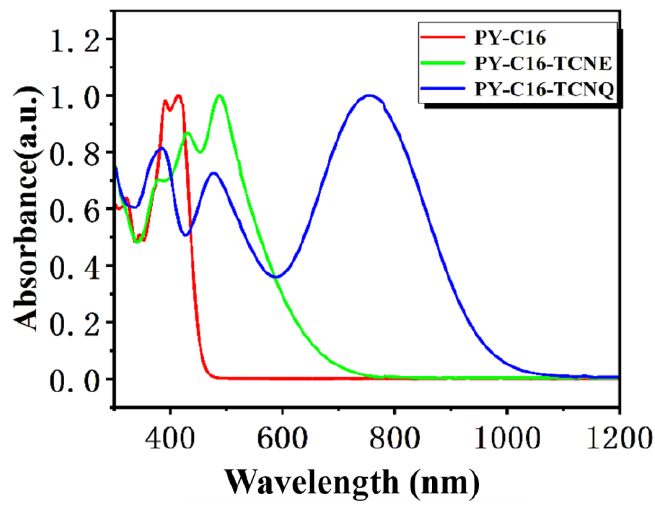
Figure 2. Normalized UV-vis absorption spectra of compound PY-C16 and click products PY-C16- TCNE, PY-C16-TCNQ measured in dichloromethane solution with a concentration of 10 − 5 M.